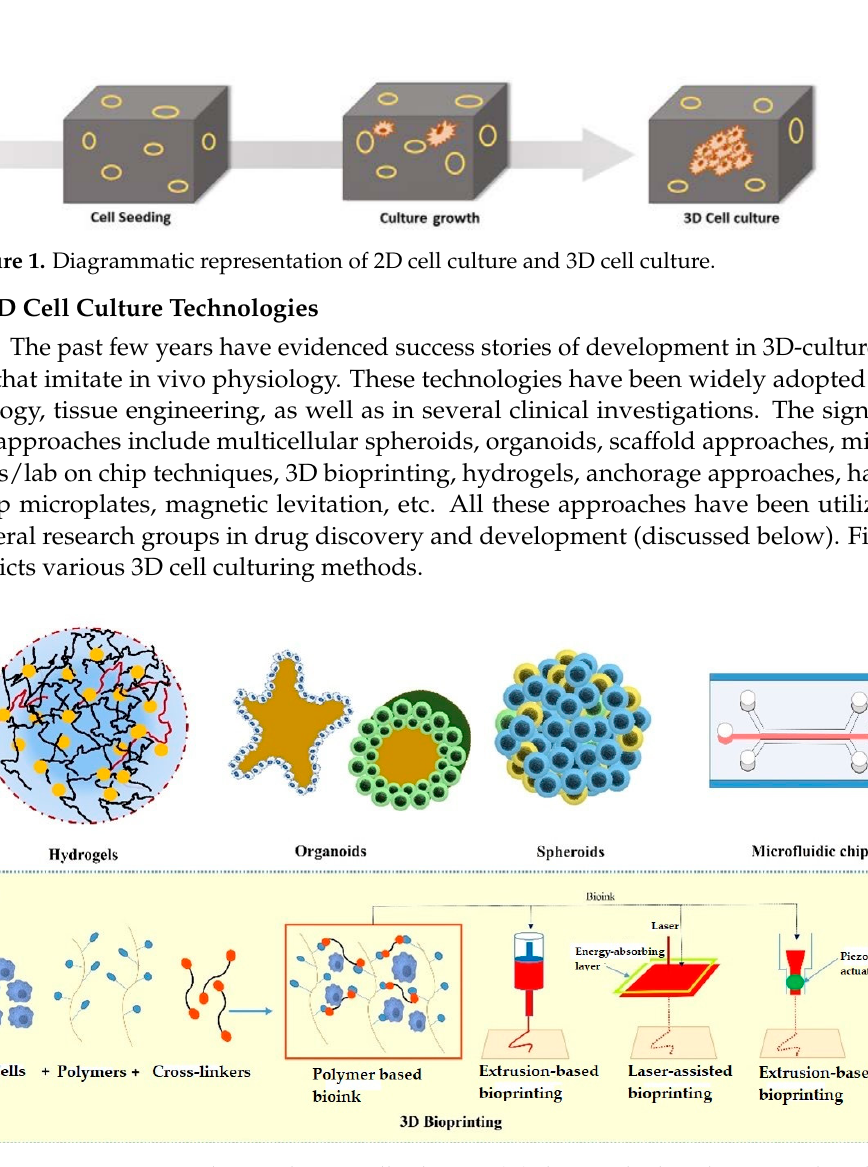
Figure 2. Various approaches used in 3D cell culturing; ( A ): showing hydrogels, organoids, sphe- roids, and microfluidic chip, ( B ) showing the extrusion-based, laser-assisted, and inkjet-based meth- ods used in 3D